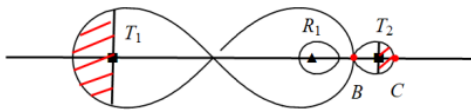
> d 2 2 1 1 2 d d  . 2 1